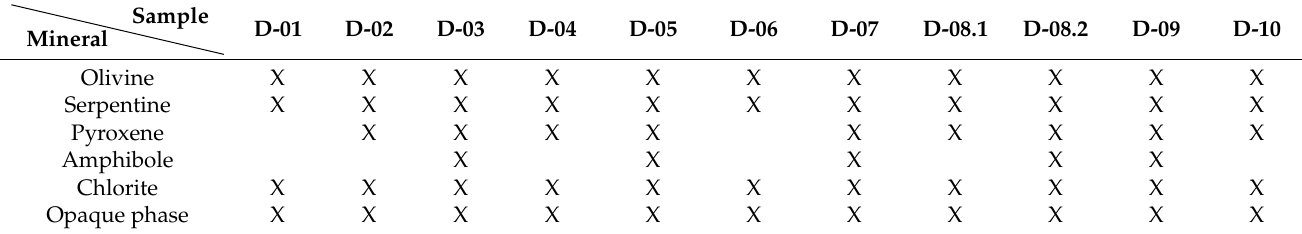
Table 4. Results of the microscopic analysis of the thin sections, showing the most frequent minerals [34]. Mineral